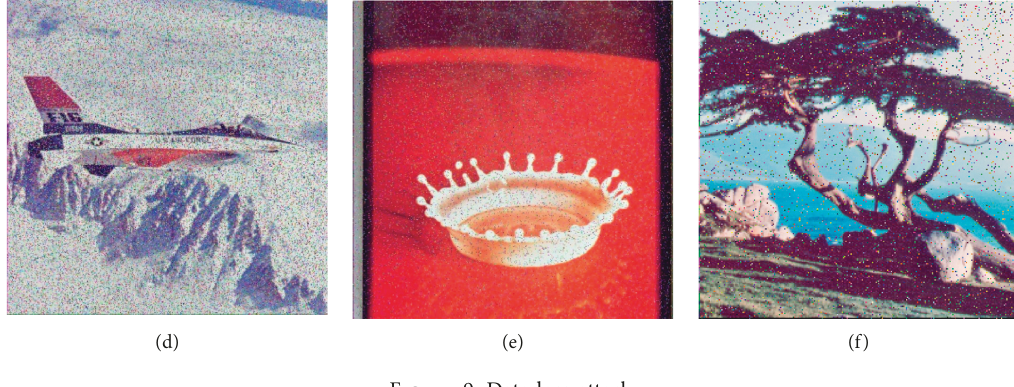
Figure 9: Data loss